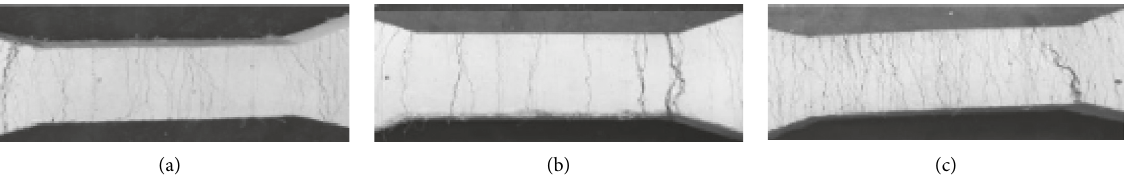
Figure 7: Failure phenomenon of PE-ECC with different water-binder ratios under single mineral powder: (a) 7 days, (b) 28 days, (c) 60